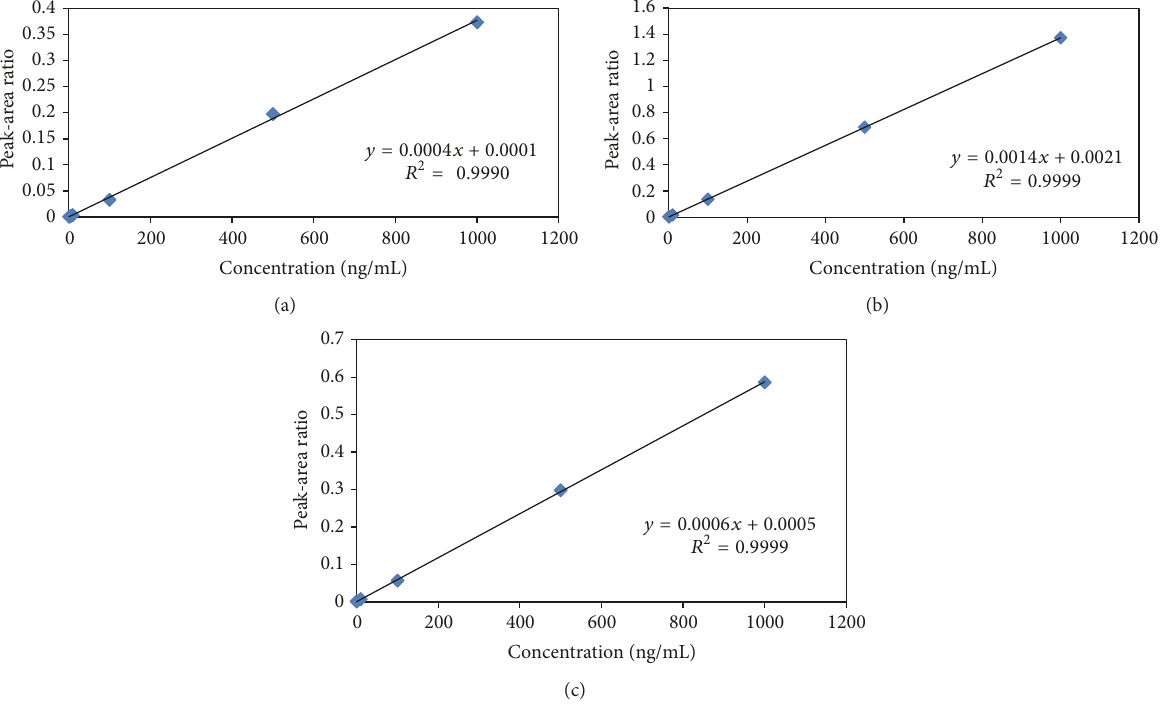
Figure 5: Standard calibration curves of (a) FLX, (b) RIS, and (c)